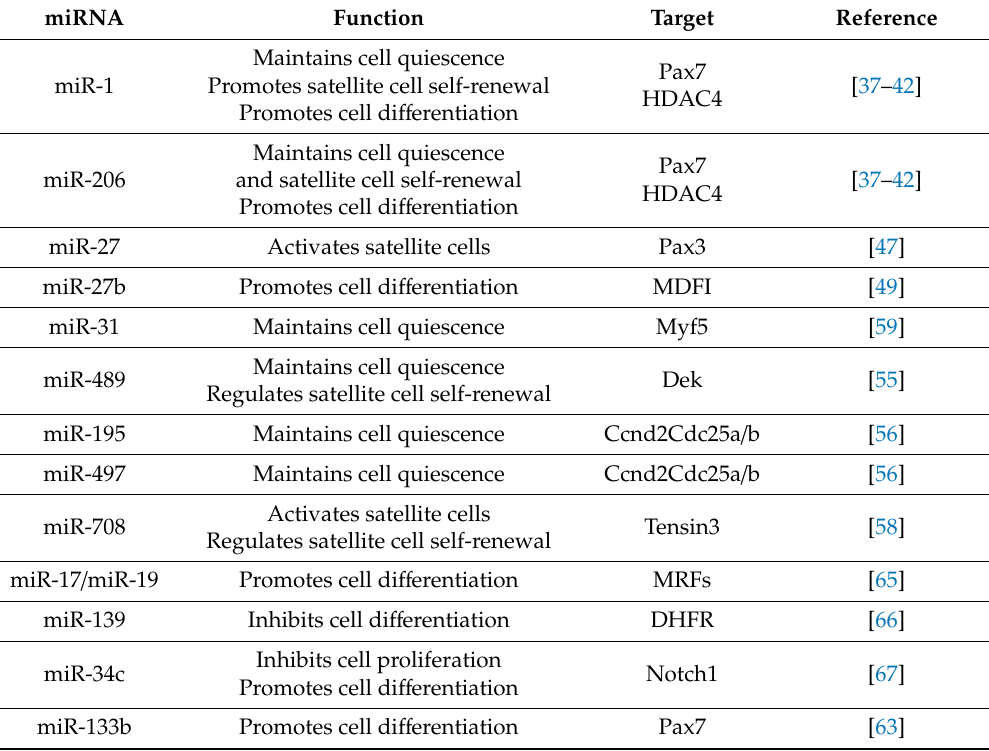
Table 1. microRNAs (miRNAs) and targets in the myogenesis of skeletal muscle satellite